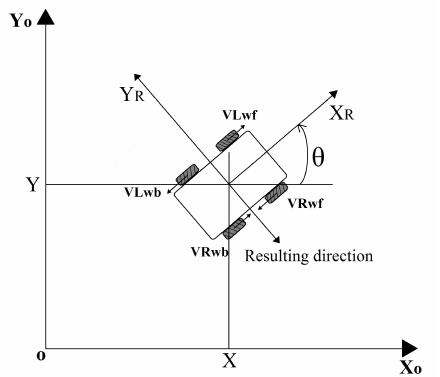
Figure 7. A lateral motion example of an omnidirectional